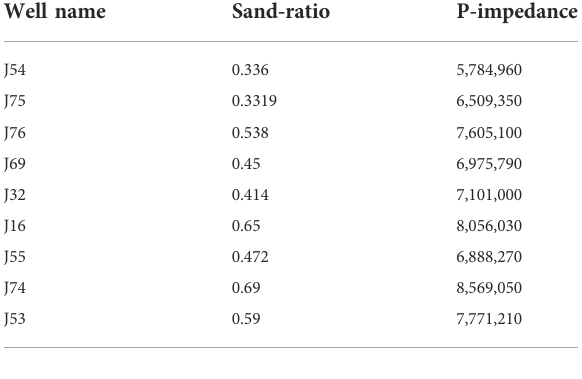
TABLE 2 Statistics for T9c-T9d sand-ratio and p-Impedance of nine studied wells.